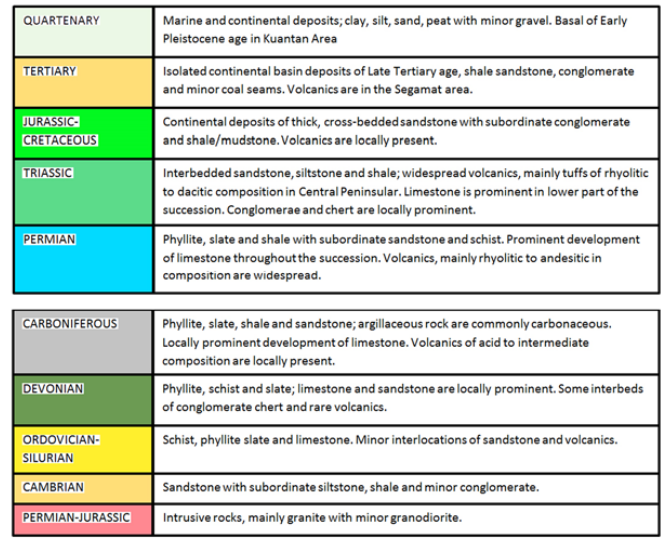
Figure 8. Geological Map of the HSR Malaysia route, modified from [25].